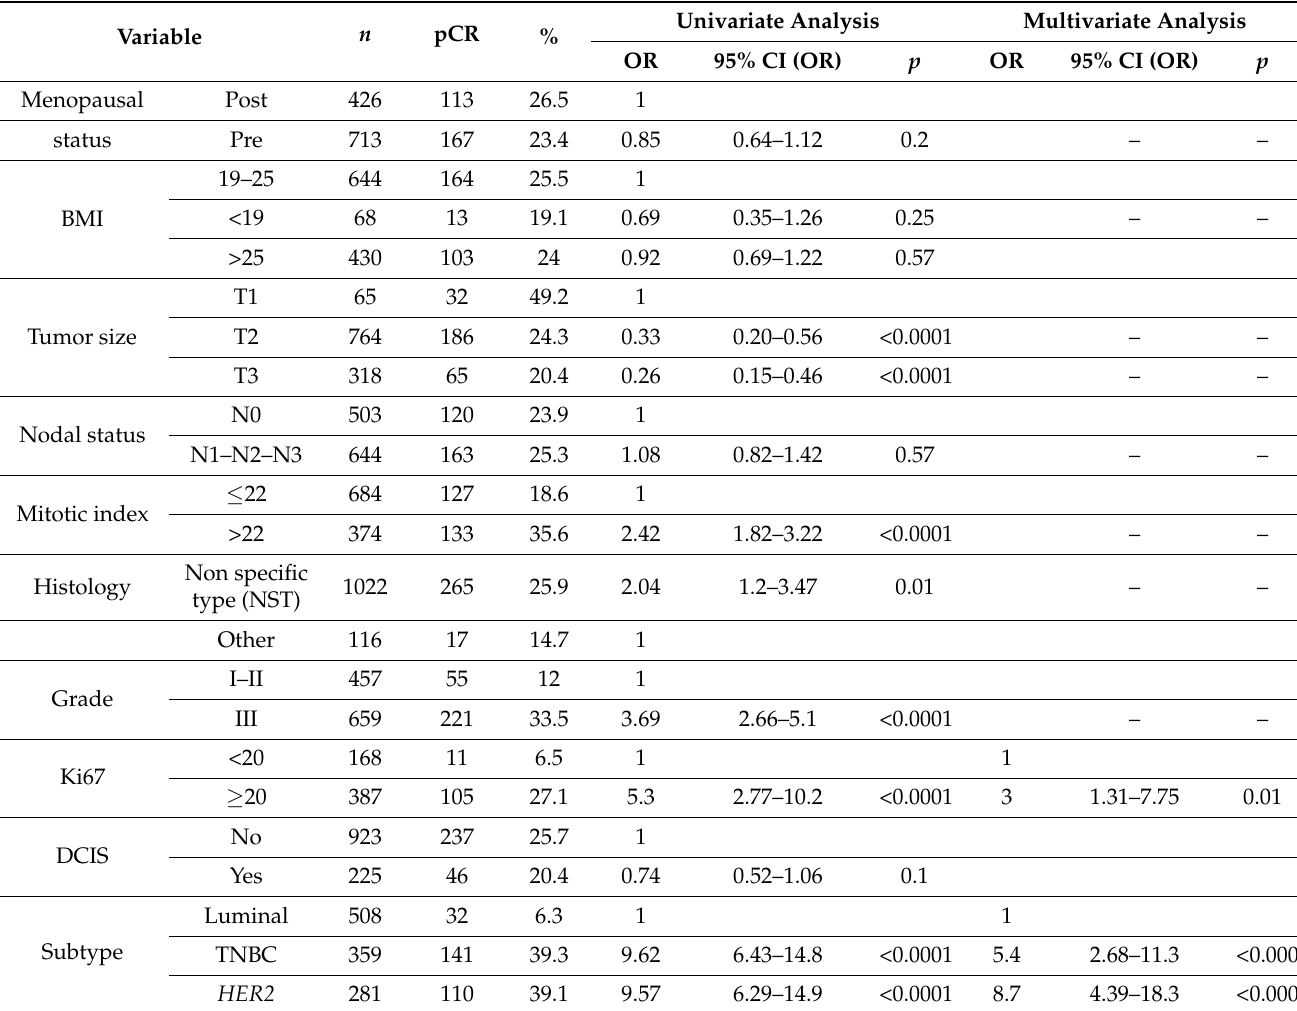
Table 4. Association of baseline clinical and pathological factors with